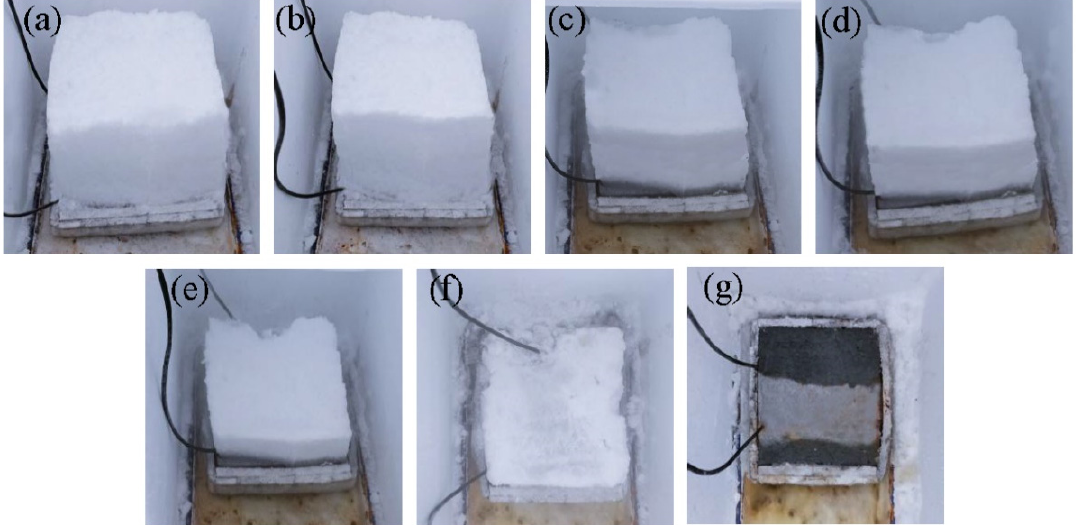
Figure 12. Real-time snowmelt diagram: ( a ) 0 min, ( b ) 20 min, ( c ) 40 min, ( d ) 60 min, ( e ) 80 min, ( f ) 100 min, ( g ) 120 min.